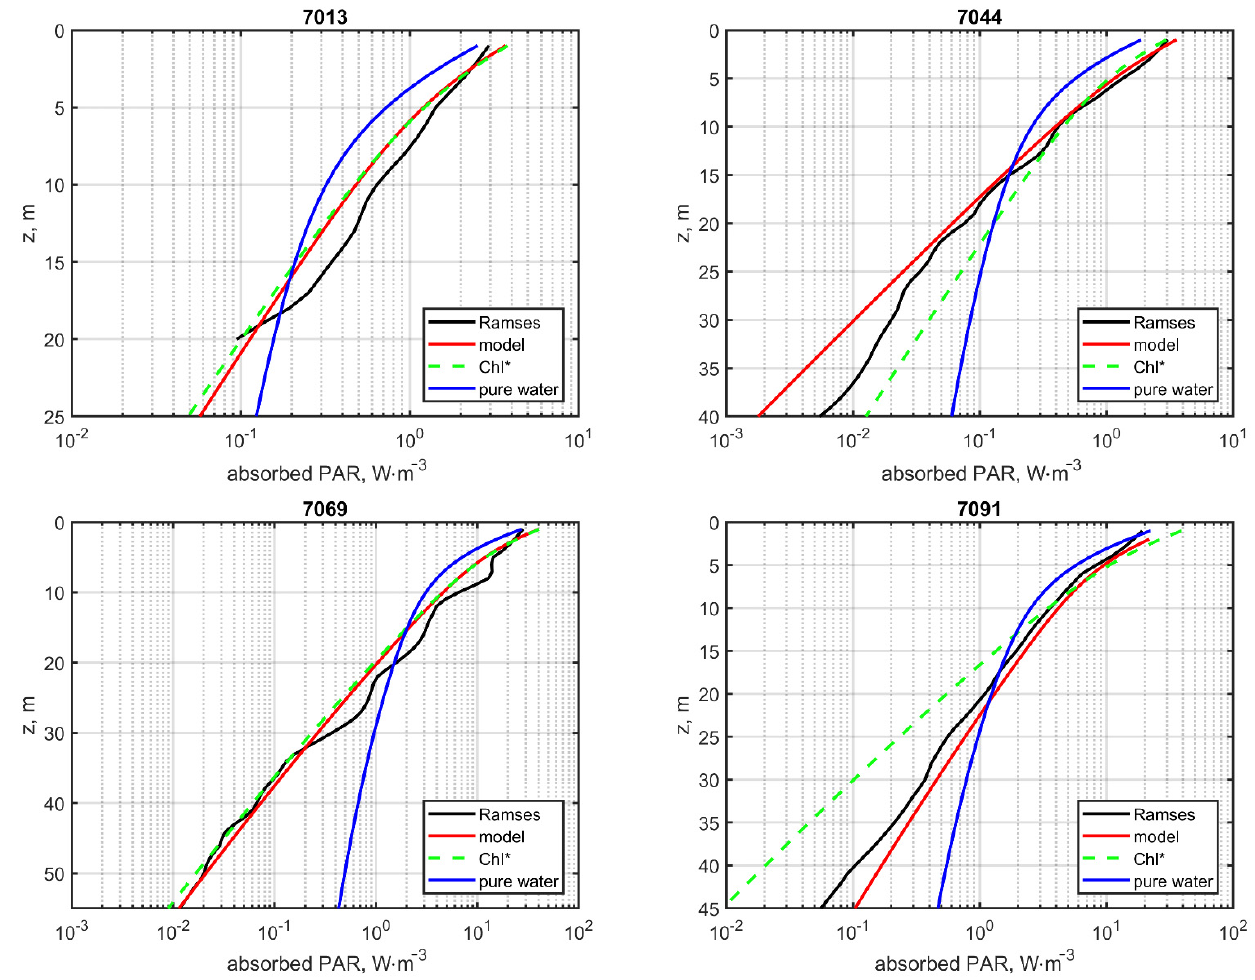
Figure 8. Vertical distributions of solar energy absorbed in seawater in the PAR range drawn from direct measurements (black lines) and modeling based on in situ measurements (red lines), selected Chl * values (green dotted lines), and the pure water hypothesis (blue lines).